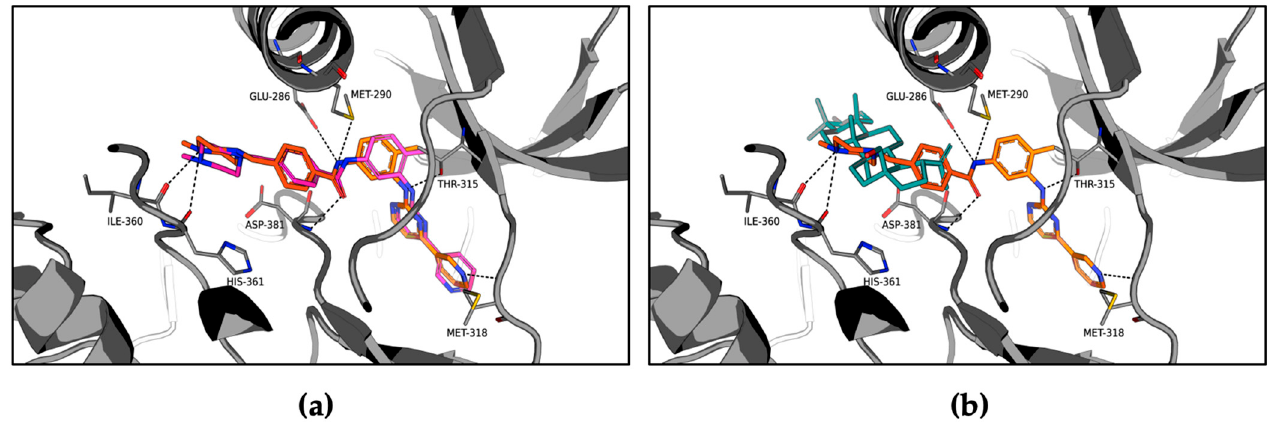
Figure 4. In silico docking analysis of the interaction between the ATP binding site of ABL1 and imatinib or betulin. ( a ) The binding orientation and interactions of imatinib with the ABL1 tyrosine kinase as exhibited in the crystal structure (orange, PDB code: 1IEP) compared to the orientation predicted with molecular docking (magenta). ( b ) The binding orientations and interactions of imatinib (orange) and betulin (teal) with the ABL1 tyrosine kinase ATP binding site as predicted by molecular docking.